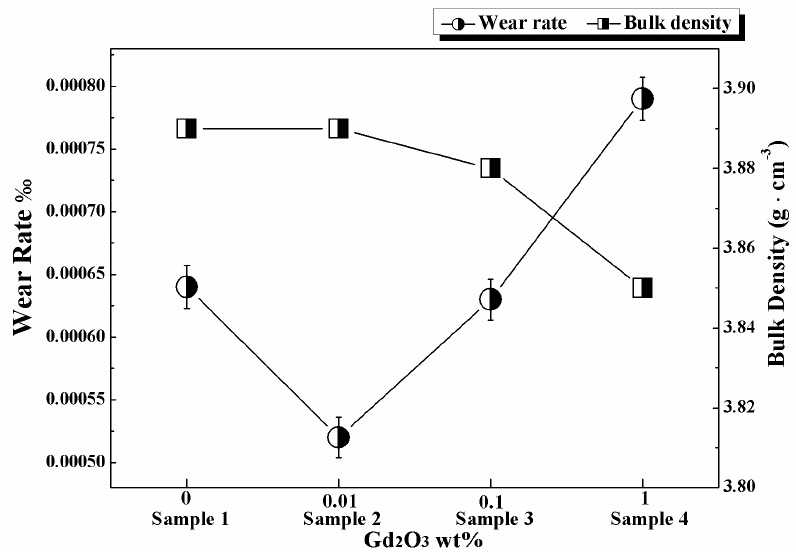
Figure 1. Relationship between Gd 2 O 3 content, wear rate, and bulk density.